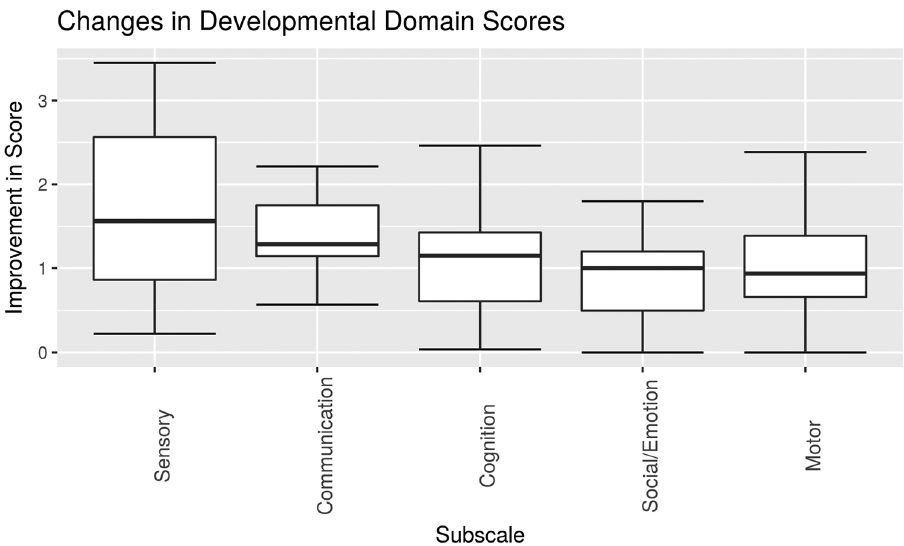
Figure 7: Box plot showing distributions of changes in scores by domain across the study.